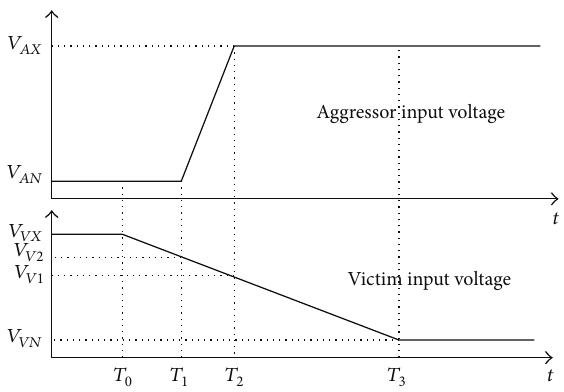
of the aggressor line on the delay of the voltage at the end of the victim line. For this purpose, we define the input voltages of the aggressor and victim lines, as shown in Figure